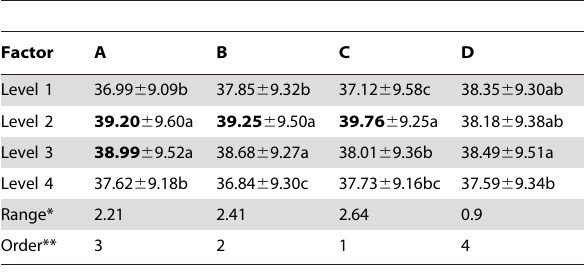
Table 5. Average responses of each level and range of Plumular length (mm). N